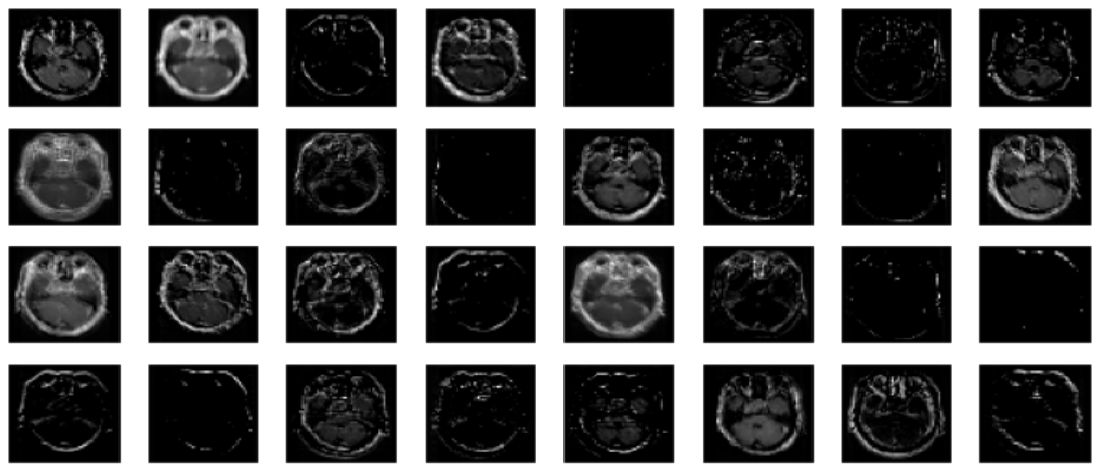
Fig. 4 Second feature maps of 32 filters